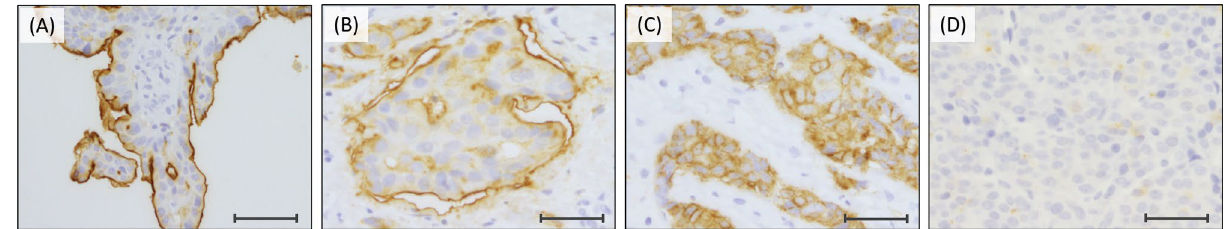
Figure 1. Representative images of MUC1 staining. Representative images of MUC1 staining are shown. ( A ) Apical, ( B ) apical + cytoplasmic, ( C ) cytoplasmic, ( D ) negative. The horizontal bar indicates 100 µm.